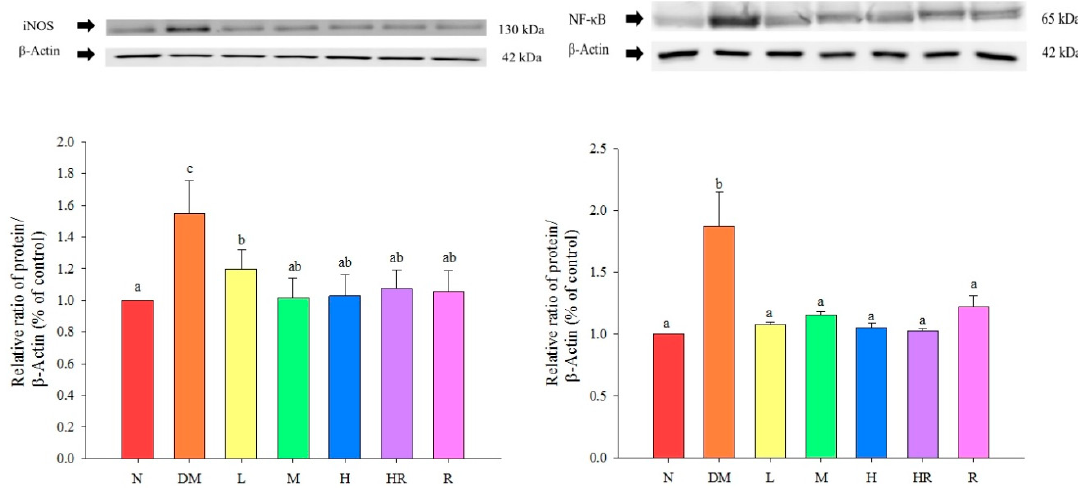
Figure 2. Influence of red guava on iNOS and NF- κ B inflammatory protein expression in mouse livers. The treatments were as follows: normal (N), diabetes mellitus (DM), diabetes + red guava 1% (L), 2% (M), and 5% (H), diabetes + 5% red guava + anti-diabetic rosiglitazone (HR), and diabetes + anti-diabetic rosiglitazone (R). Values are expressed as mean ± SD of each group. The lowercase letters above the bars indicate significant differences ( p < 0.05).